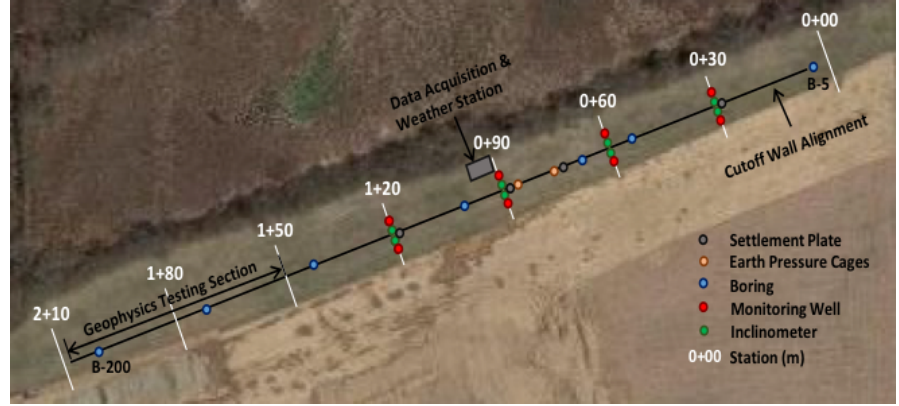
Figure 3. Location of the instrumentation at the test